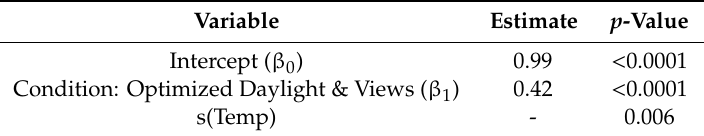
Table 5. Generalized additive mixed effect model of the effect of condition on average cognitive function scores, normalized to the Blinds condition, controlling for temperature and treating participant as a random effect.